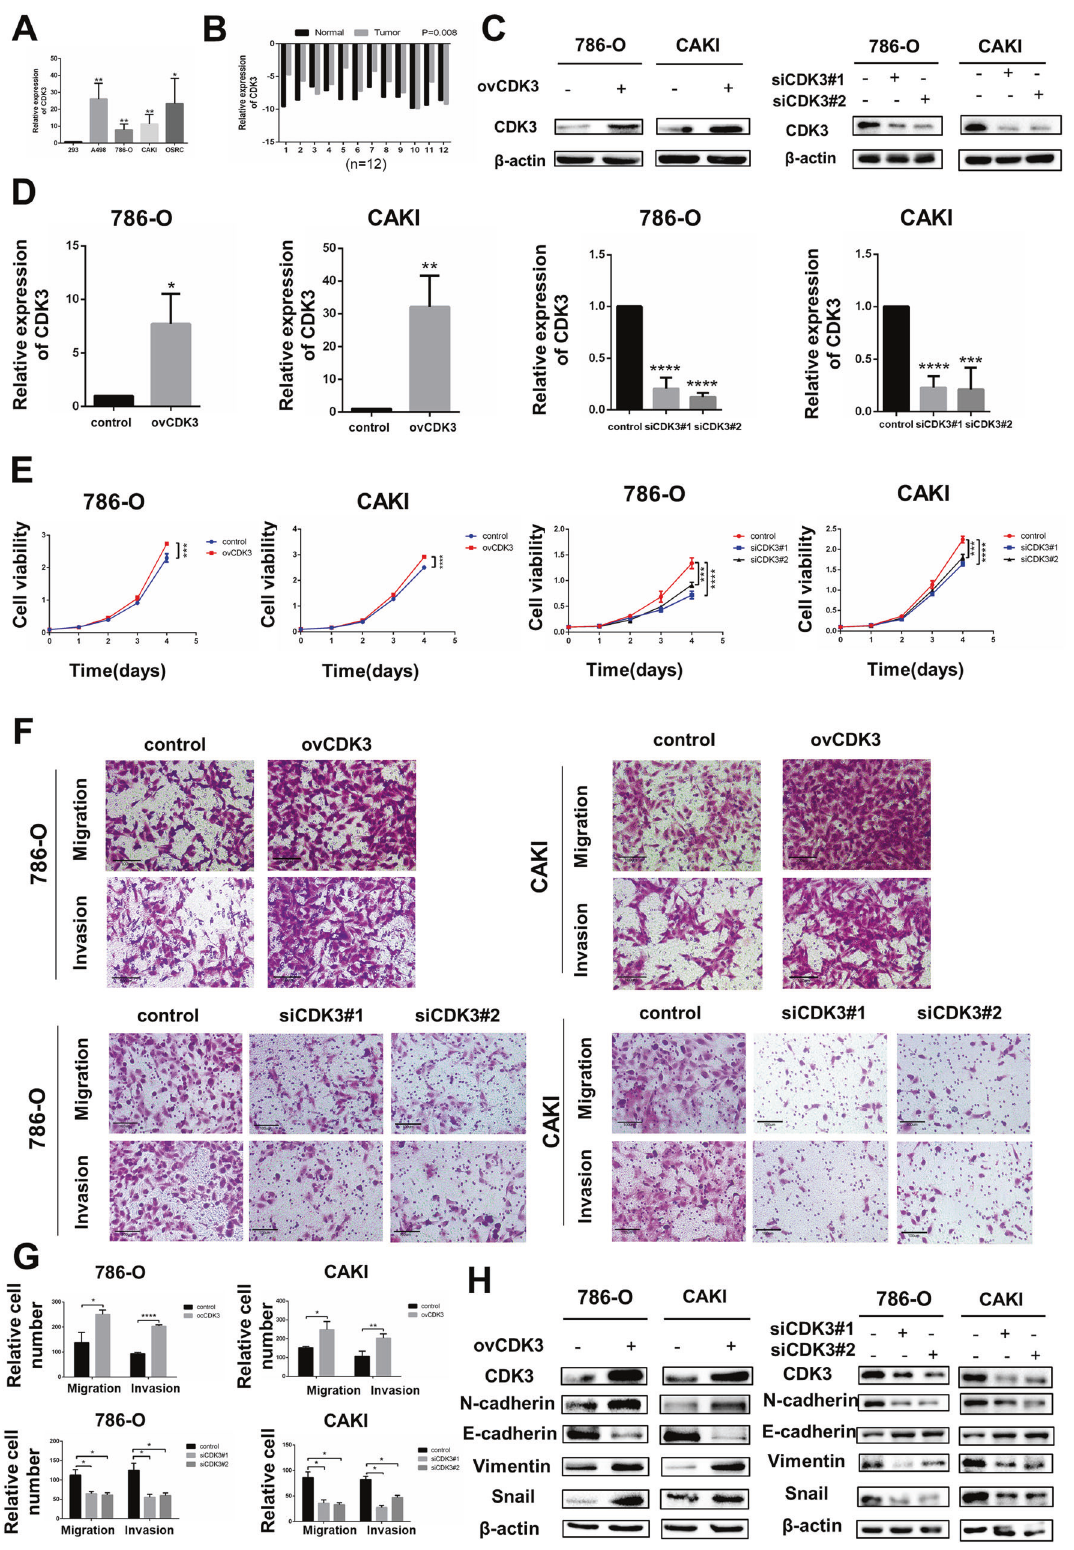
Fig. 6 CDK3 was up-regulated in RCC and promoted its metastasis. A The mRNA levels of CDK3in ccRCC cells. B The mRNA levels of CDK3 in 12 pairs of ccRCC tissues and neighboring normal tissues. C , D CDK3 protein and mRNA expression after overexpression or knockdown. E Cell growth curves of CCK8 assays for indicated cells. F , G Migration and invasion assay for overexpressing or knockdown CDK3 (Magni fi cation: 200×). t -test, * p < 0.05, ** p < 0.01,*** p < 0.001, **** p < 0.0001. H The expression change of EMT markers in overexpressing CDK3 cells or siCDK3